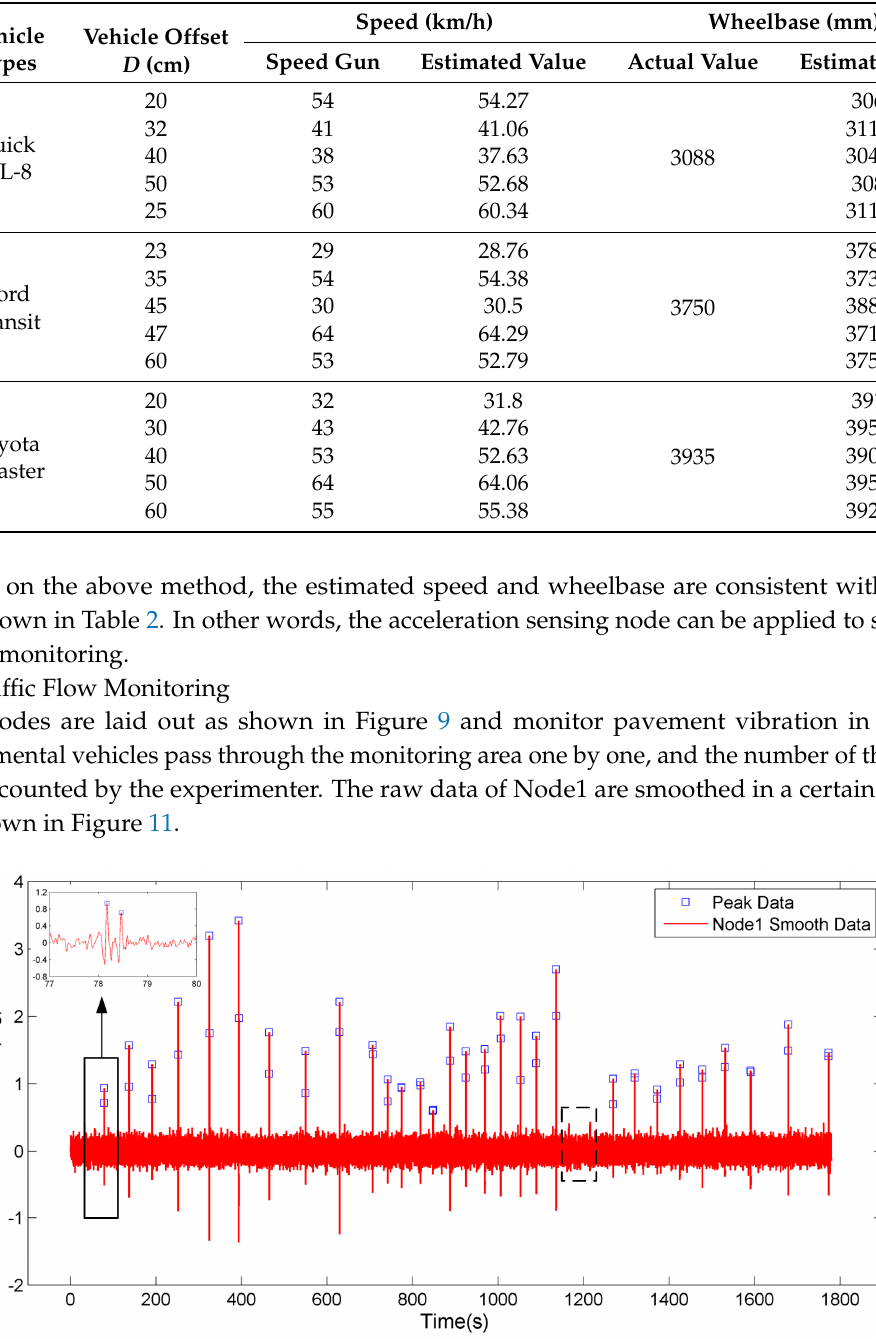
Table 2. Vehicle speed and wheelbase estimates.